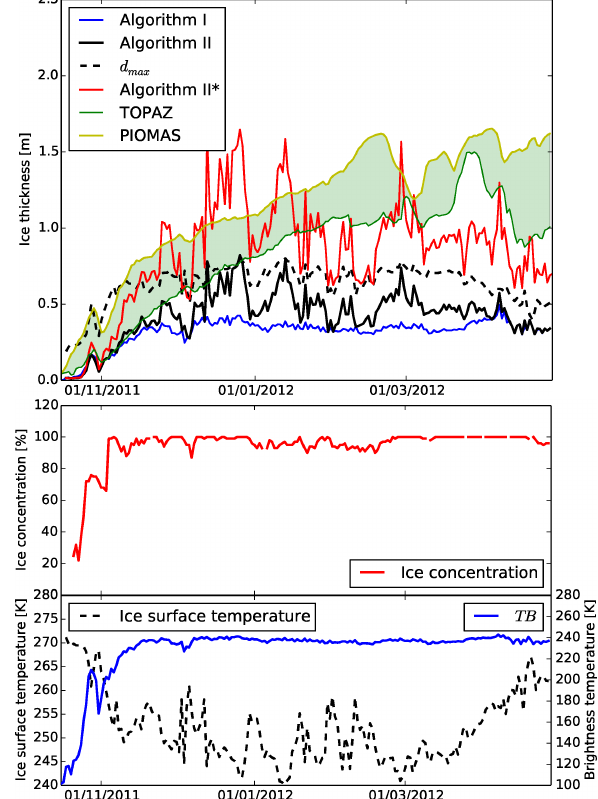
Figure 11. Time series of ice thickness derived from Algorithm I, II, and II*, together with d max and simulated ice thicknesses from TOPAZ and PIOMAS (upper panel) and time series of ice concen- tration (middle panel), snow (or ice in the case of bare ice) sur- face temperature and SMOS TB (lower panel) at Point 1 (77.5 ◦ N, 137.5 ◦